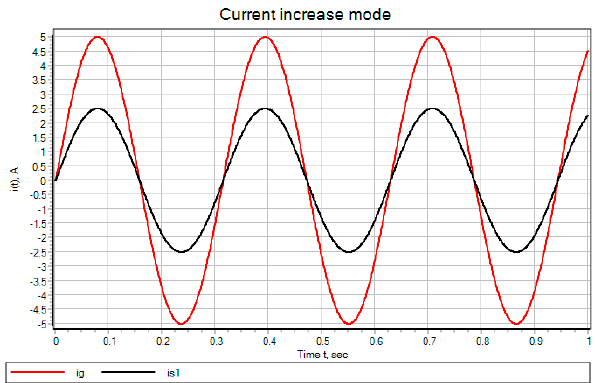
Figure 11. Generator voltage produced when the stator windings were connected in parallel.